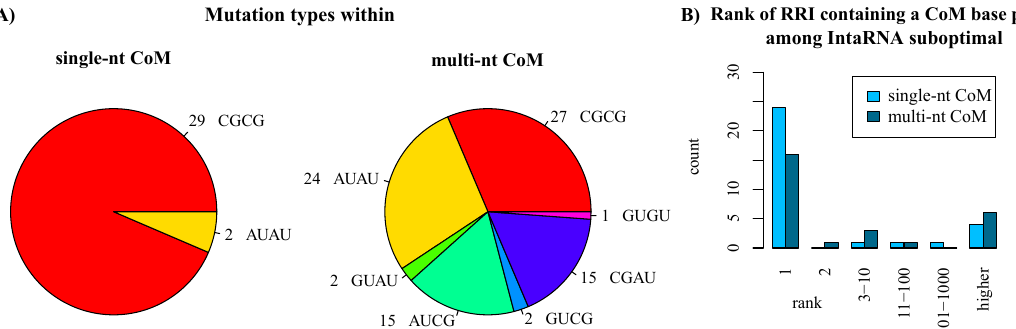
Figure 3. Characteristics of CoMs known from the literature. ( A ) Distribution of mutation types where the first two letters encode the wildtype nucleotides and the last two the respective mutated bases (both lex-sorted to reduce classes). For instance, AUCG represents both an AU or a UA wildtype base pair mutated either to CG or GC; ( B ) Rank of the RRI containing a CoM base pair among IntaRNA’s energy-sorted suboptimal RRI